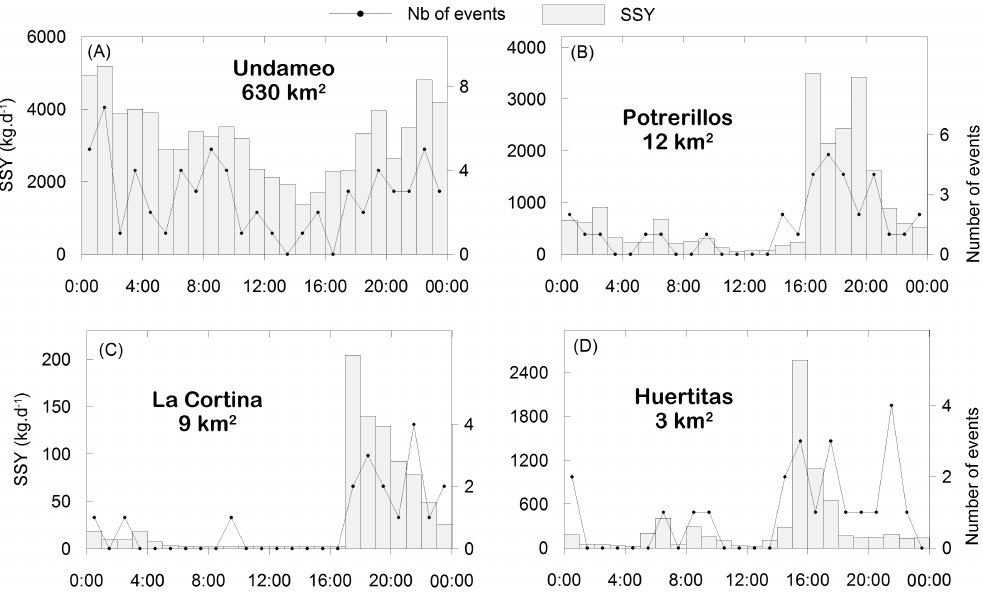
Fig. 5. Distribution of daily SSY in 2009 at the four stations. Black line plots correspond to the number of peak flow events per